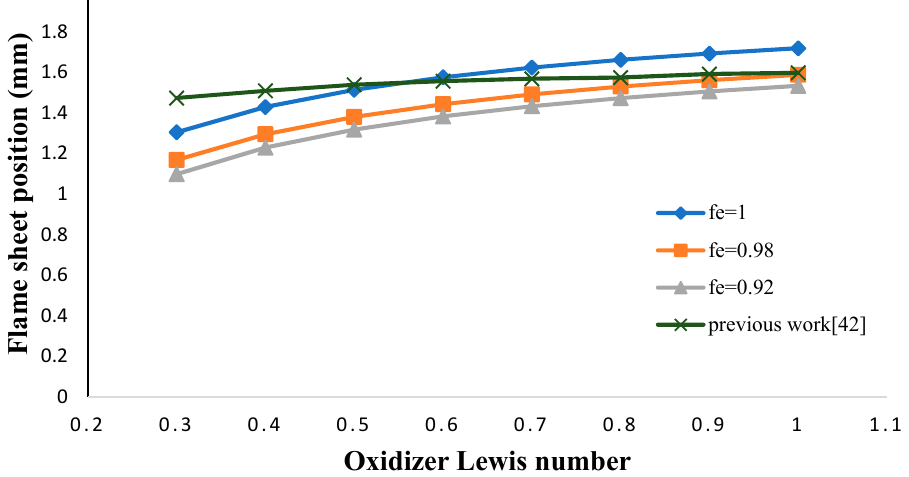
Figure 7. Flame sheet position against the oxidizer Lewis number for different porosity factors.